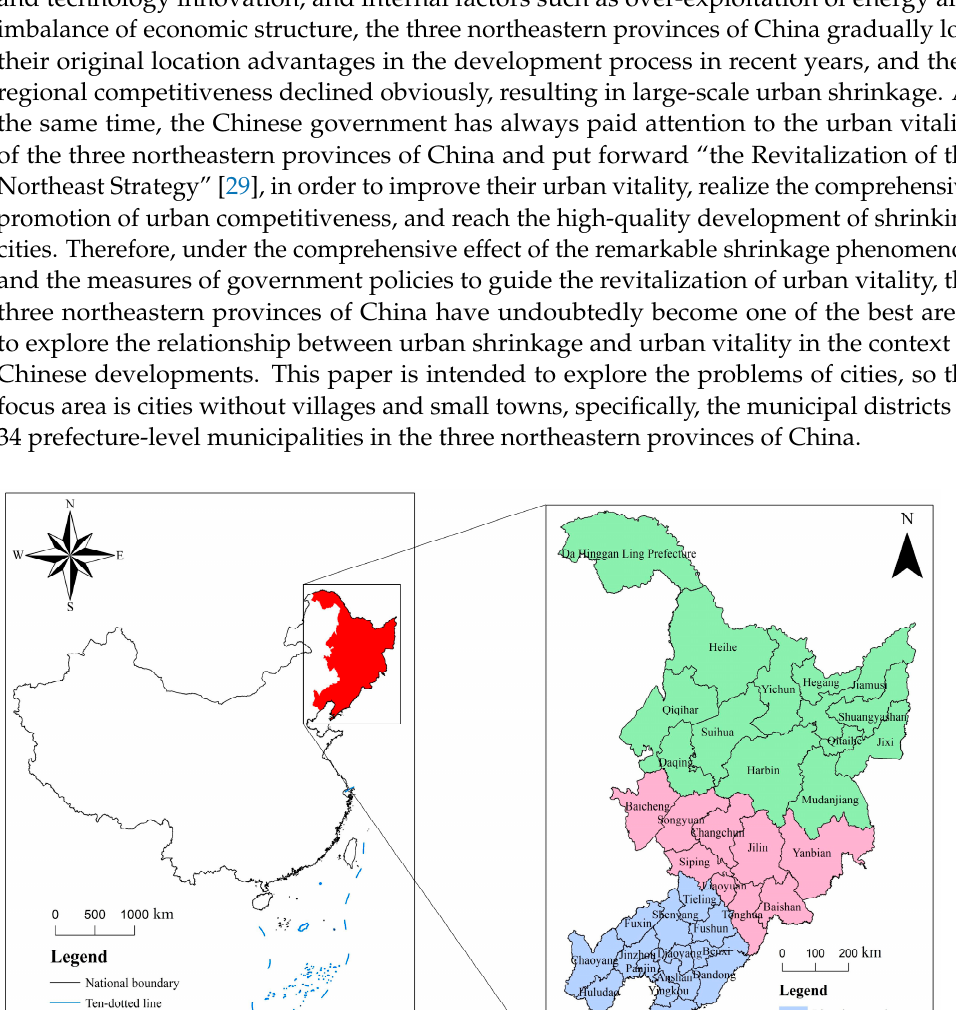
Figure 1. The theoretical connection between urban shrinkage and urban vitality.